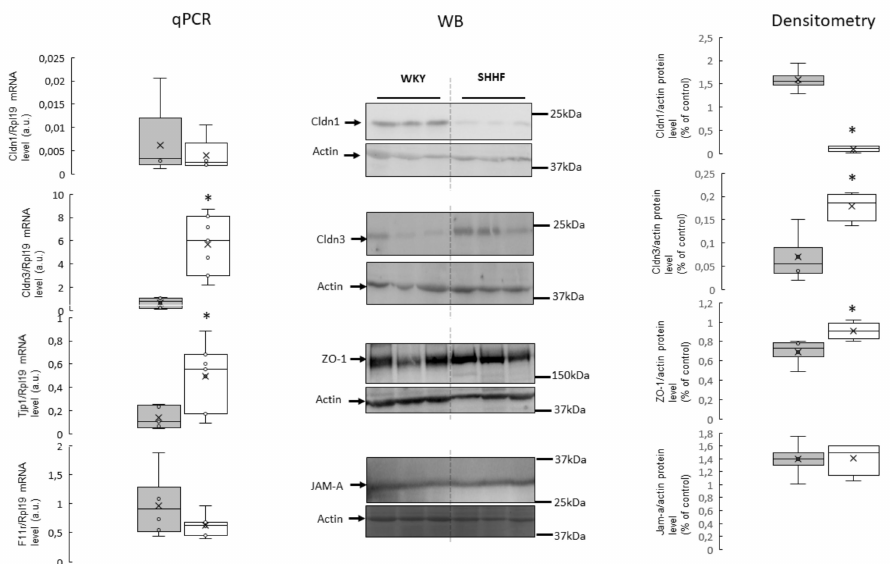
Figure 3. RT-qPCR analysis of claudin 1 (Cldn1), claudin 3 (Cldn3), zonula occludens-1 (ZO-1), and F11r transcript levels in the colon of WKY and SHHF rats (displays on histogram use arbitrary units), (means ± SD, n = 6–7). Western blot analysis of Cldn1, Cldn3, ZO-1 and junctional adhesion molecule A (JAM-A) protein levels from total protein extract prepared from the colon. A representative immunoblot is shown. Immunolabeled Cldn1, Cldn3, ZO-1, JAM-A and beta actin loading control bands were quantified using a Molecular Imager. The relative levels of the test proteins are plotted in arbitrary unit (means ± SD), grey bars—Wistar Kyoto rats, white bars—spontaneously hypertensive heart failure rats, * p < 0.05 by t -test.